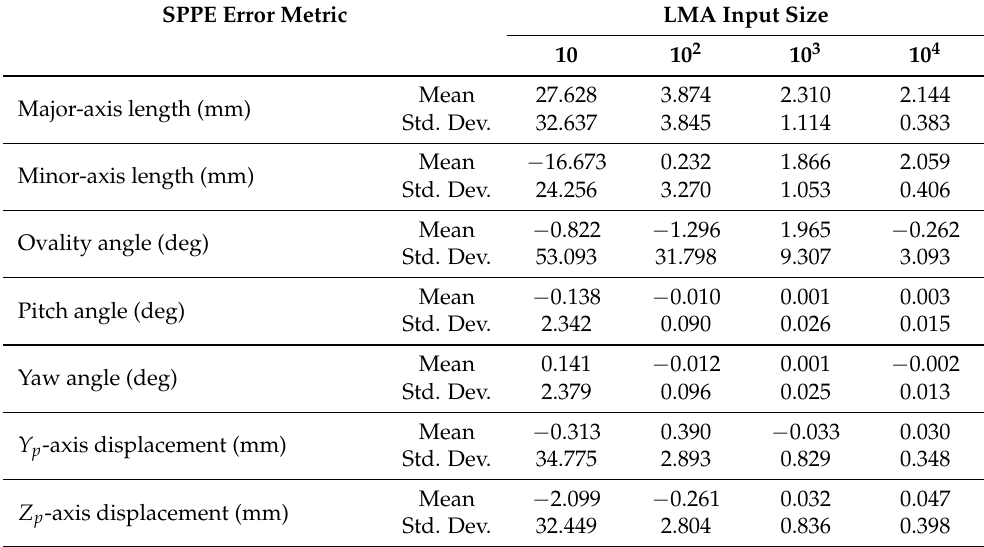
Table 2. SPPE estimation results for different LMA input